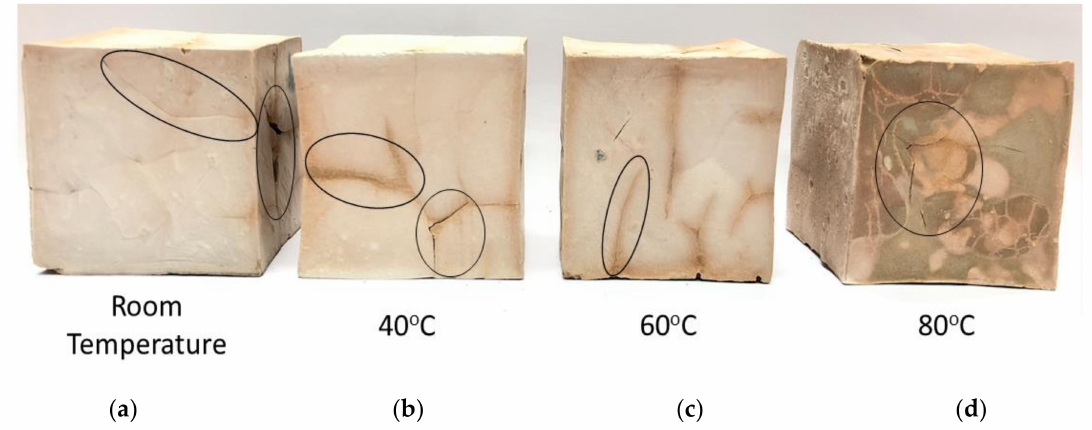
Figure 8. Visual appearance of kaolin-GGBS geopolymer samples with different curing temperatures. ( a ) Room temperature, ( b ) 40, ( c ) 60, and ( d ) 80 ◦